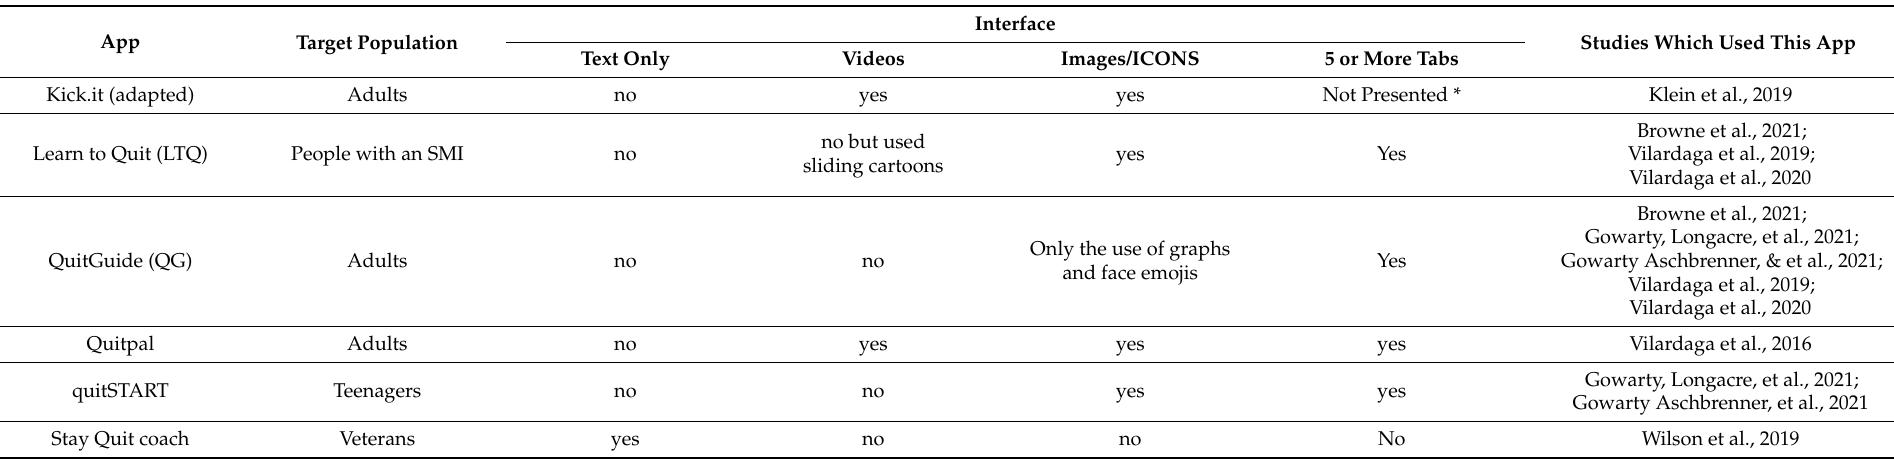
Table 3. Summary of the user interface of the